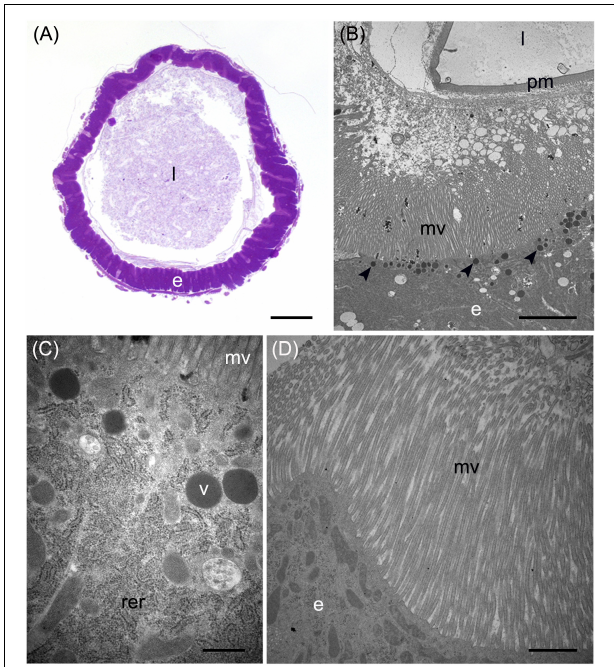
FIGURE 7 | Morphological organization of the posterior midgut (PMG1 and PMG2). (A) Cross-section of PMG1. (B,C) : rough endoplasmic reticulum (rer), microvilli (mv), and electron-dense vesicles (arrowheads in B , v in C ) in the apical part of columnar cells in PMG1. (D) Microvilli (mv) of the epithelial cells in PMG2. e: epithelium; l: lumen; pm: peritrophic matrix. Bars: 100 µ m (A) , 5 µ m (B) , 500 nm (C) , 1 µ m (D) .